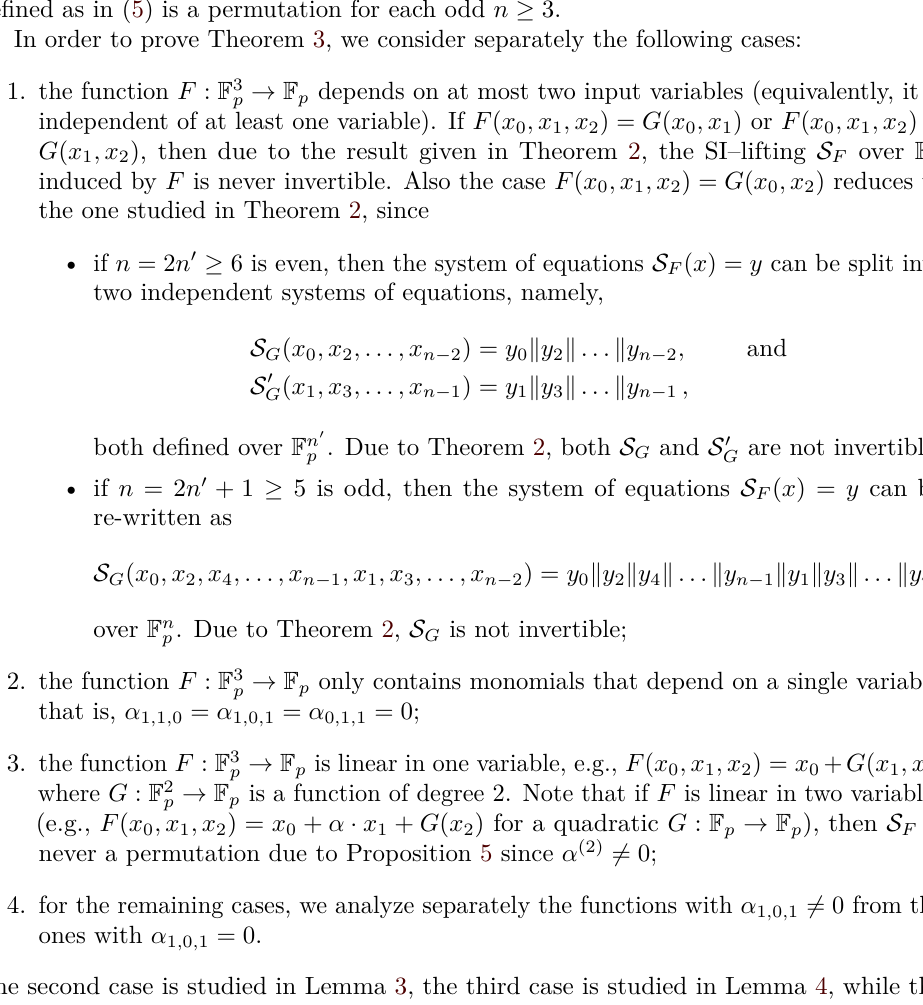
Table 3 for the case of quadratic functions F : F m number and the percentage of balanced functions, the maximum value of n ≥ 3 tested and the total